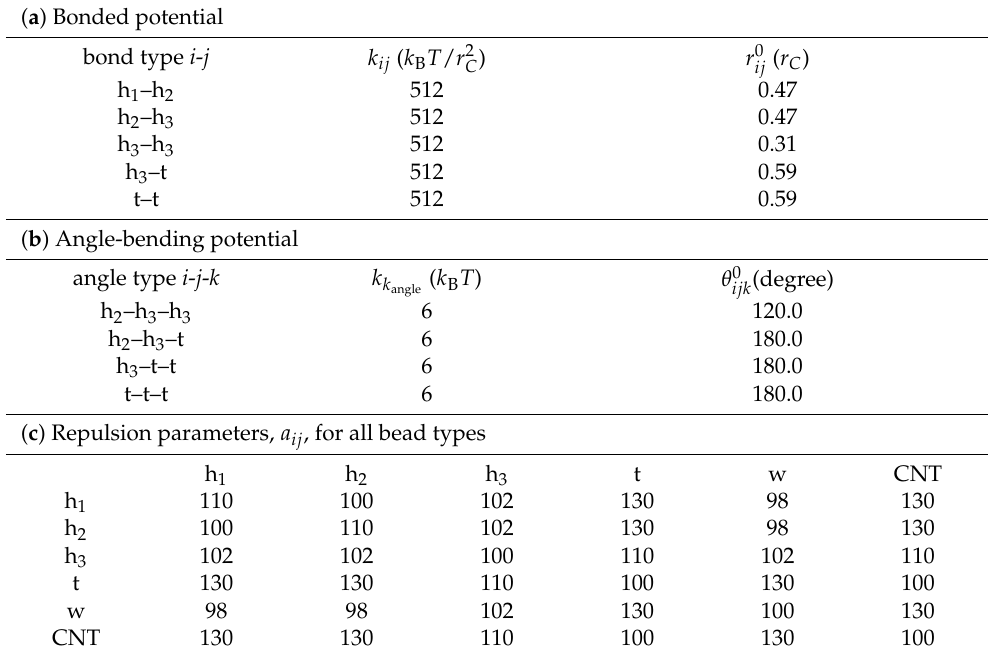
Table 1. DPD parameters for DPPC, water, and carbon nanotubes